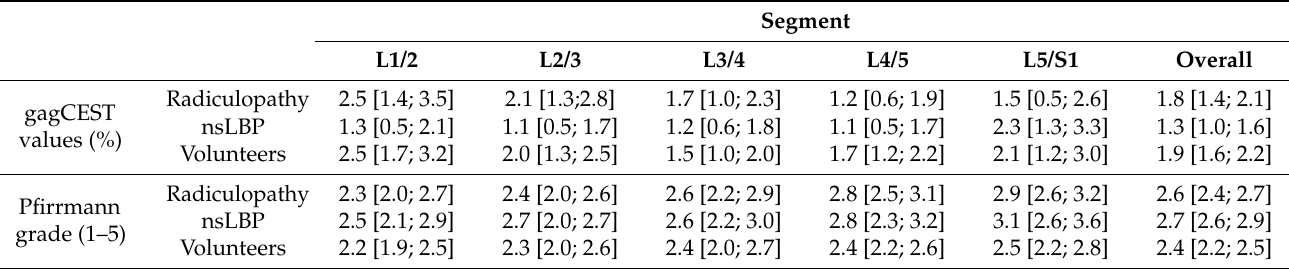
Table 3. Mean imaging measures as a function of the study cohort, i.e., patients with radiculopathy, non-specific low back pain (nsLBP) and asymptomatic volunteers, and intervertebral disc (IVD) segment level, i.e., L1/2–L5/S1. Data are given as means [99% confidence intervals]. Glycosaminoglycan chemical exchange saturation transfer (gagCEST) values were compared using a linear mixed model comprising a subject-specific random intercept, while the Pfirrmann grades were compared using the Kruskal–Wallis test followed by Dunn’s post-hoc test wherever